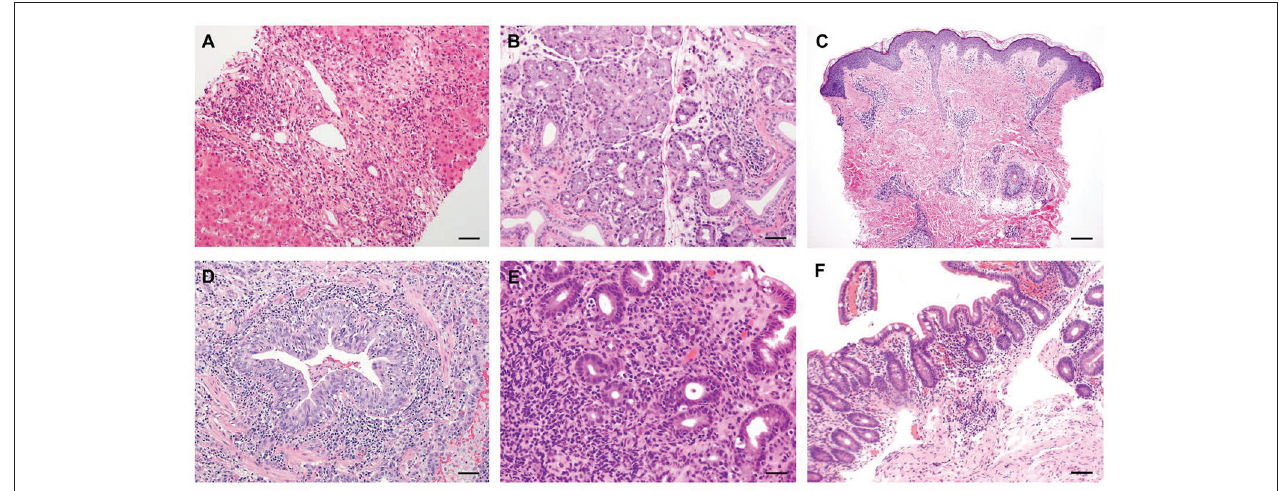
FIGURE 2 | Representative histological features of common non-endocrine manifestations in APECED patients. (A) A liver biopsy displaying severe chronic hepatitis with expansion of portal areas by inflammation and fibrosis and extensive interface hepatitis with numerous plasma cells infiltrating into the hepatic parenchyma (H&E; scale bar: 50 µ m; original magnification, × 200). (B) A minor salivary gland biopsy depicting lymphocytic and plasma cell infiltration in and around the ducts of the gland (H&E; scale bar: 50 µ m; original magnification, × 200). (C) Skin biopsy of a patient with APECED rash demonstrates perivascular and periadnexal inflammation in the superficial and deep dermis with pallor of the papillary dermis (H&E; scale bar: 2mm; original magnification, × 40) (D) An open lung biopsy revealing chronic bronchiolitis with lymphocytic infiltration within and around the bronchiolar mucosa and lymphoid aggregates in the interstitium nearby (H&E; scale bar: 50 µ m; original magnification, × 200). (E) A stomach biopsy exhibiting chronic antral inflammation with lymphoplasmacytic infiltrates in the lamina propria and occasionally on glands (H&E; scale bar: 50 µ m; original magnification, × 200). (F) A jejunal biopsy depicting mild villus blunting and focal acute inflammation (H&E; scale bar: 50 µ m; original